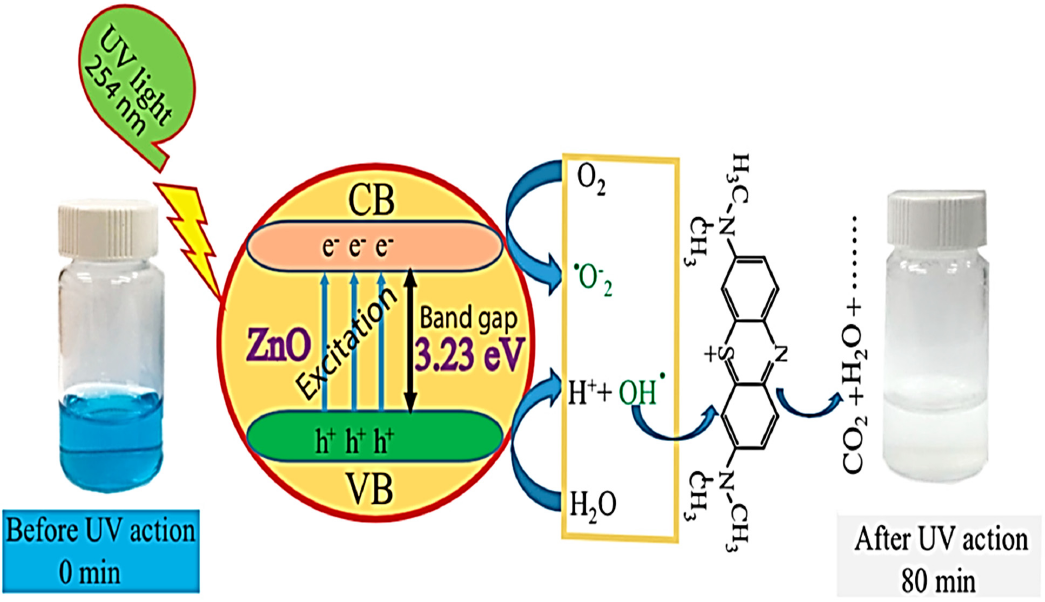
Figure 6. Proposed photocatalytic mechanism of ZnO-NPs for the catalytic degradation of MB dye [190].